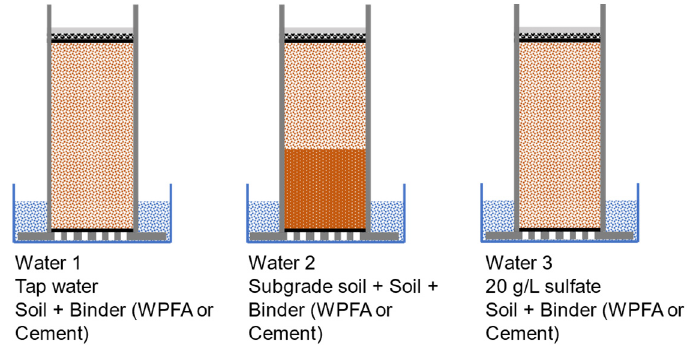
Figure 7. Water bath and different sulfate solutions.